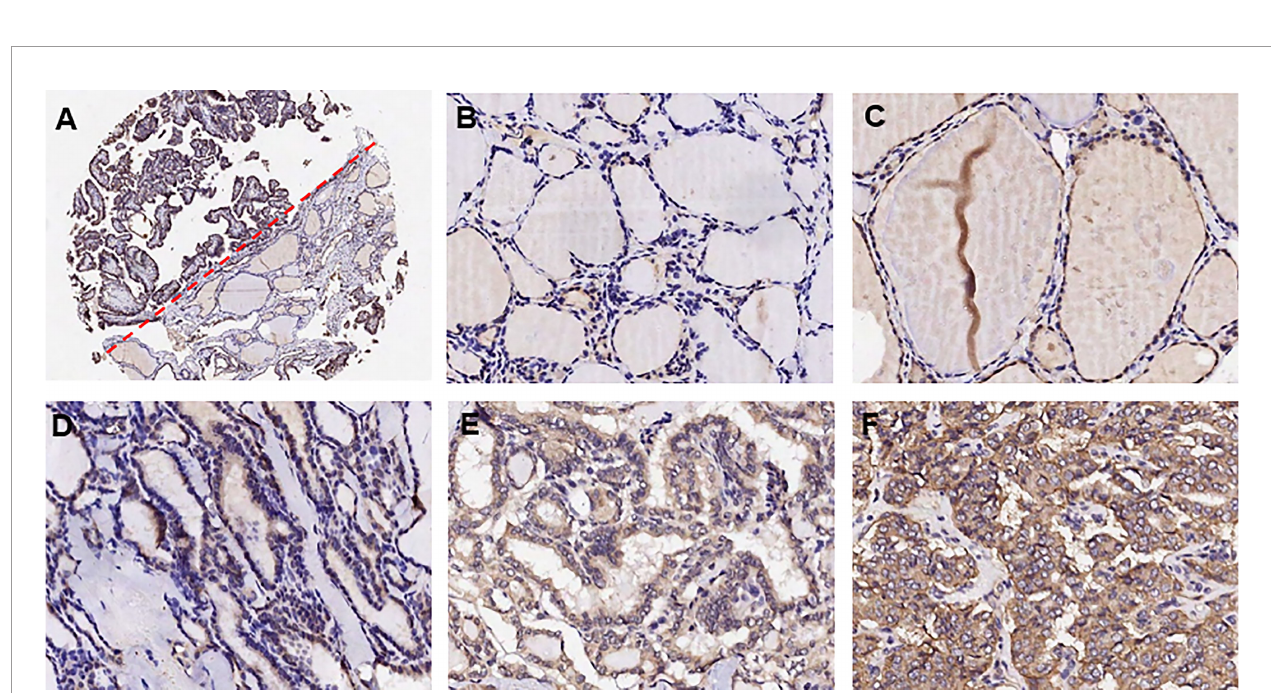
FIGURE 8 | Detection of ITG a -3 in papillary thyroid cancer and adjacent normal gland. ITG a -3 is mainly located in the cytoplasm. (A) Contrast of staining intensity between normal gland and PTC. (B) Weak staining of ITG a -3 in normal gland. (C) Moderate staining of ITG a -3 in normal gland. (D) Weak staining of ITG a -3 in PTC. (E) Moderate staining of ITG a -3 in PTC. (F) Strong staining of ITG a -3 in